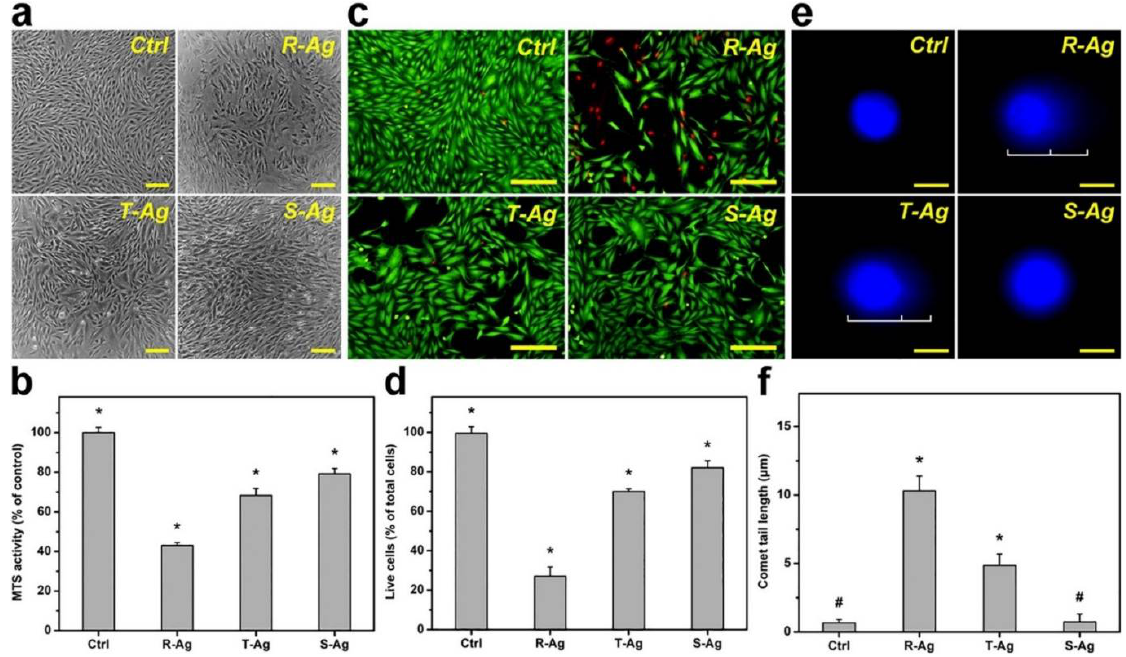
Figure 5. In vitro biocompatibility of three different shapes of AgNPs of similar size. Biocompatibility demonstrated in ( a ) Phase-contrast micrographs, ( b ) MTS activity, ( c ) fluorescence photomicrographs, and ( d ) live cells (Live/Dead assay), of Rabbit Corneal Keratocytes (RCK) cultures after a 2-day exposure to Rod shaped (R-Ag), Triangular shaped (T-Ag), and spherical shaped (S-Ag) nanoparticles at a concentration of 5 × 10 10 particles/mL. The ( e ) fluorescence photomicrographs of the comet assay, and ( f ) comet tail lengths were exposed to the three different AgNPs for 24 h at the same concentration. The controls without AgNPs are present for each experimental condition. Scale bar in ( a ) is 50 µ m, ( c ) 50 µ m, and ( e ) 10 µ m. * p < 0.05 vs all groups; # p < 0.05 vs R-Ag and T-Ag groups. Values are mean ± SD ( n = 4). Reprinted with permission from [112]. Elsevier,